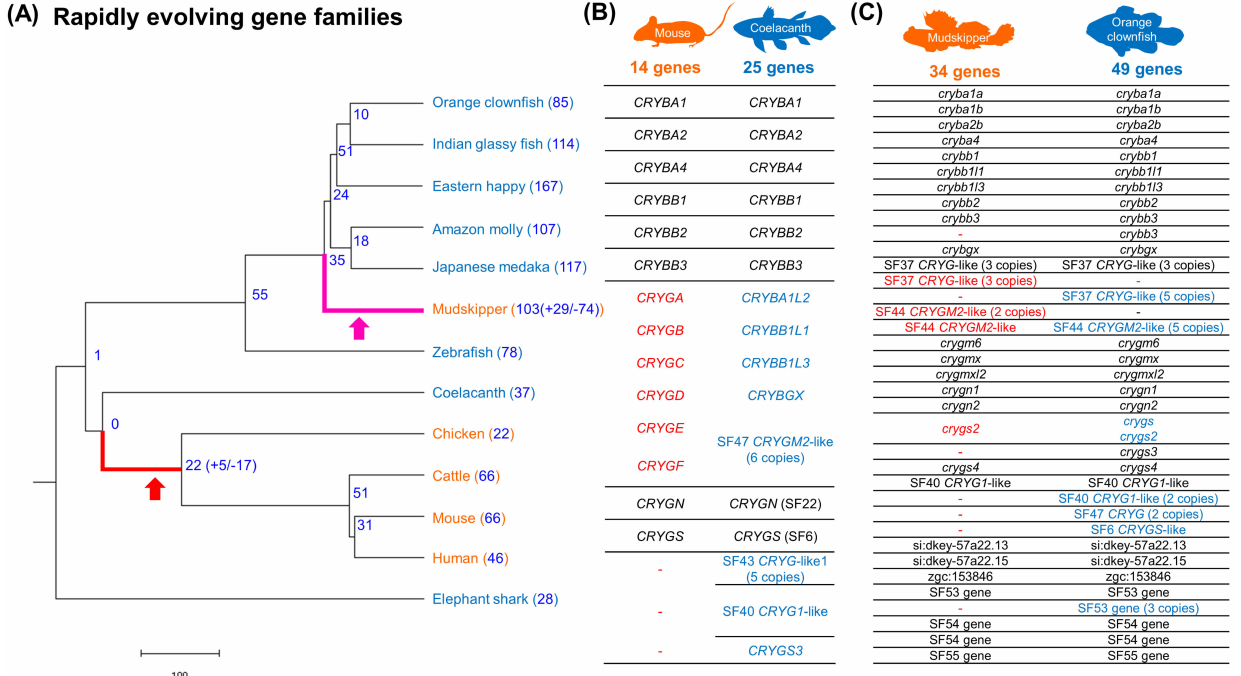
Figure 5. Rapidly evolving gene families in mudskipper and tetrapod ancestor lineages. ( A ) Phylogeny and the number of rapidly evolving gene families. Branch length indicates divergence time (million years ago). ( B , C ) Contraction of crystallin coding genes in mouse and mudskipper. Orthologous genes were within the same row. The genes without any symbol were annotated by (1) the description or (2) consensus name of their Ensembl protein family ID (PTHR11818_XXXX). Red and blue indicate the potential contraction of genes in terrestrial species and their orthologues in aquatic species,